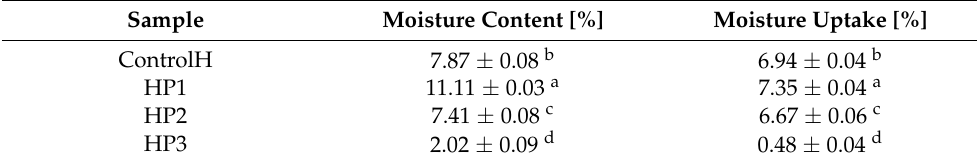
Table 5. Moisture content and moisture uptake.